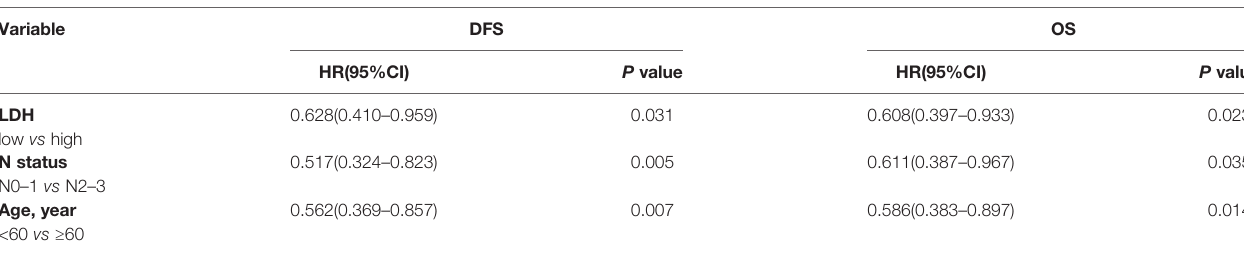
TABLE 5 | Multivariate analysis of DFS and OS for all the patients.